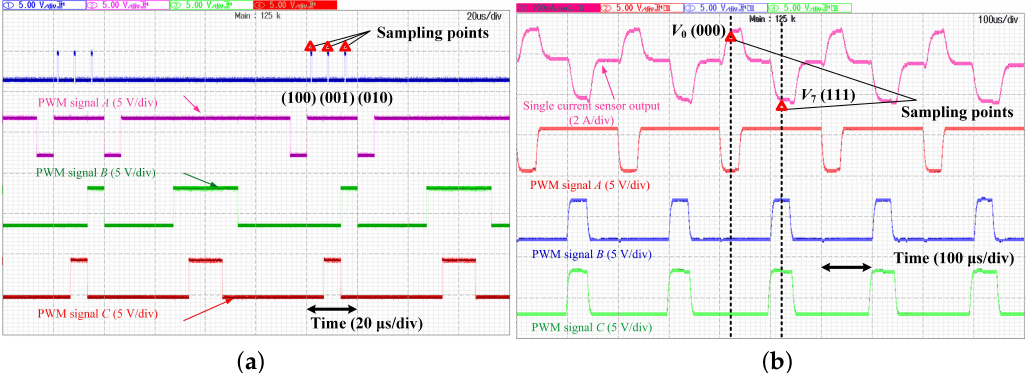
Figure 12. Sampling points and three-phase PWM signals of the two methods. ( a ) the single DC-link current sensor method; and ( b ) the novel phase current reconstruction method.